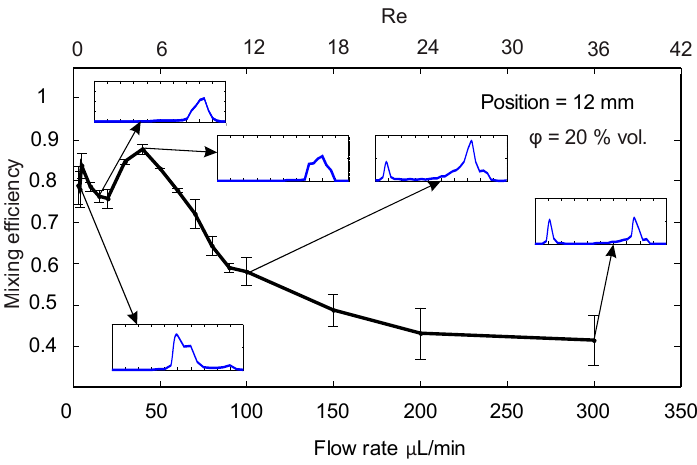
Figure 5. The effect of flow rate on mixing efficiency for a constant ferrofluid concentration of 20% at the outlet. The probability distribution graphs are indicated for the selected points.